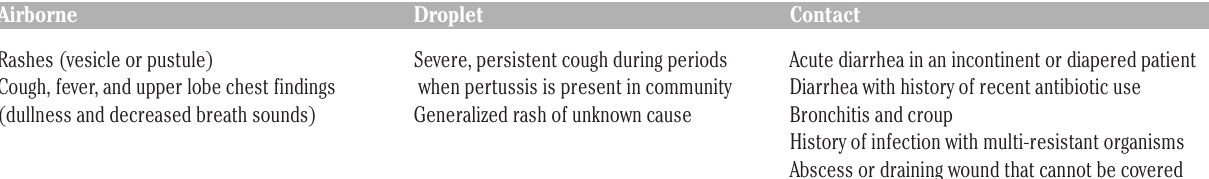
Table 3. Empiric use of transmission-based precautions.*